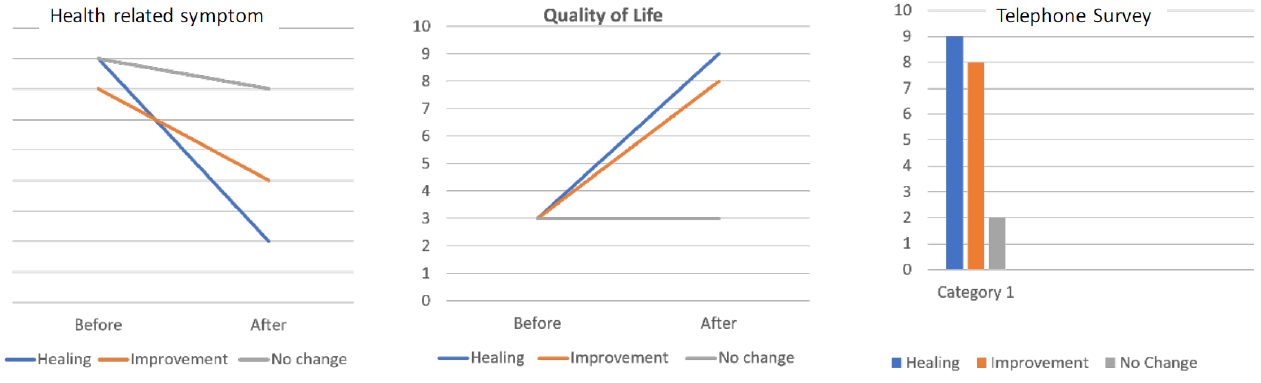
Figure 3. Results of the survey of health and symptoms, quality of life and degree of satisfaction by the telephone survey.